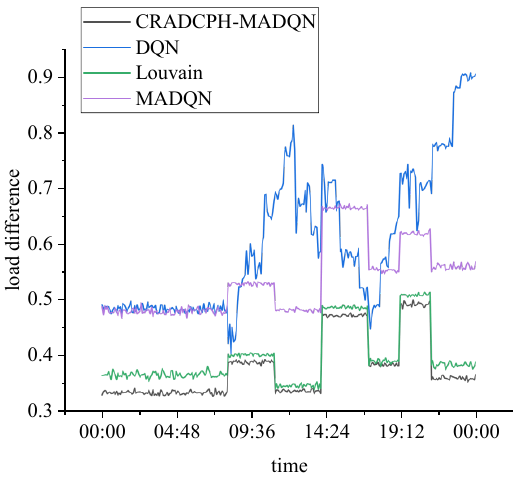
Figure 4. Load Figure 4. Load difference.